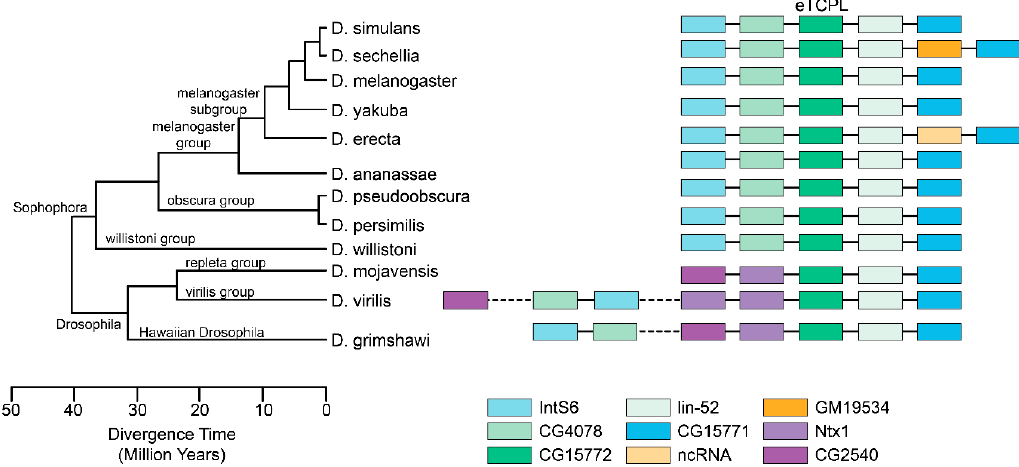
Figure 4. eTCPL gene synteny comparisons on fully sequenced genomes from Drosophila flies. The eTCPL is noted in dark green and was taken as an observation centre. Drosophila melanogaster , the most well-researched fly, was taken as a baseline and two to three genes surrounding the eTCPL were also considered. All data were collected from the FlyBase database [45], including the tree picture. In some flies whose genes surrounding the eTCPL were different, previously noted genes (IntS6 and CH4078) were also located for this analysis.